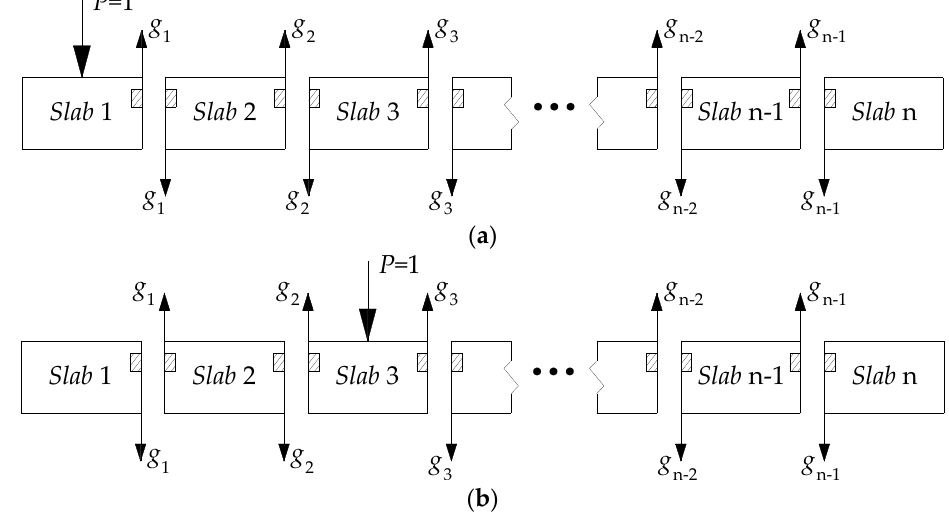
Figure 3. The basic system for shear analysis: ( a ) unit external force loaded on side slab; ( b ) unit external force loaded on internal slab.